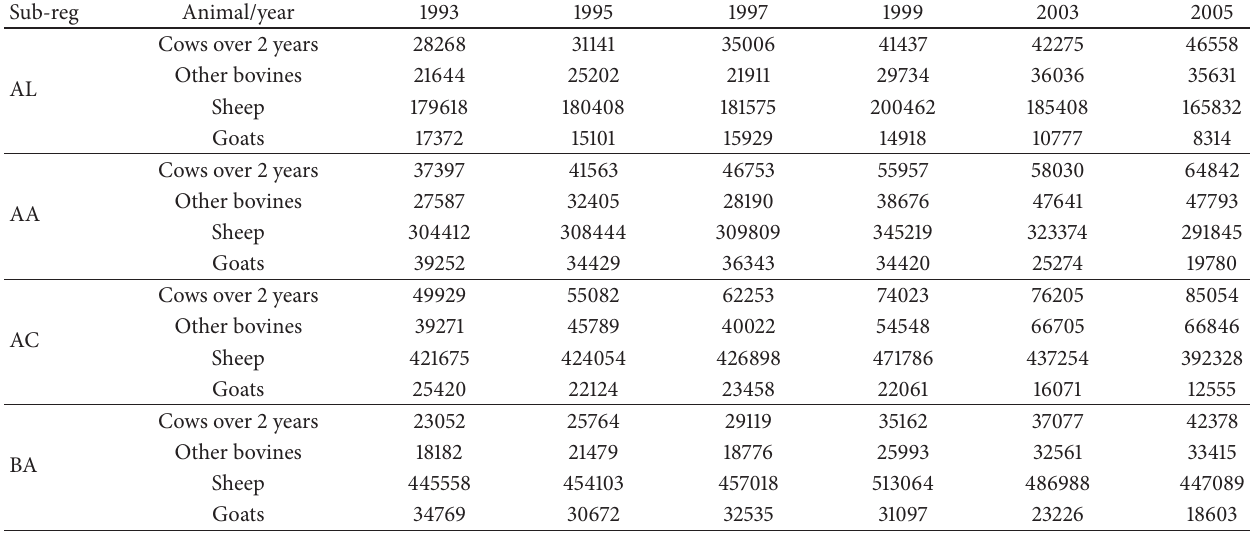
Table 4: The number of livestock estimated for each of the Alentejo’s